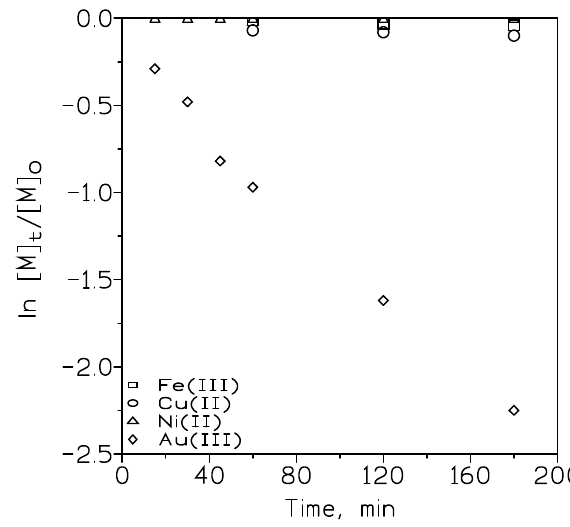
Table 7. Separation factors for the transport of gold(III) in the presence of other metals.